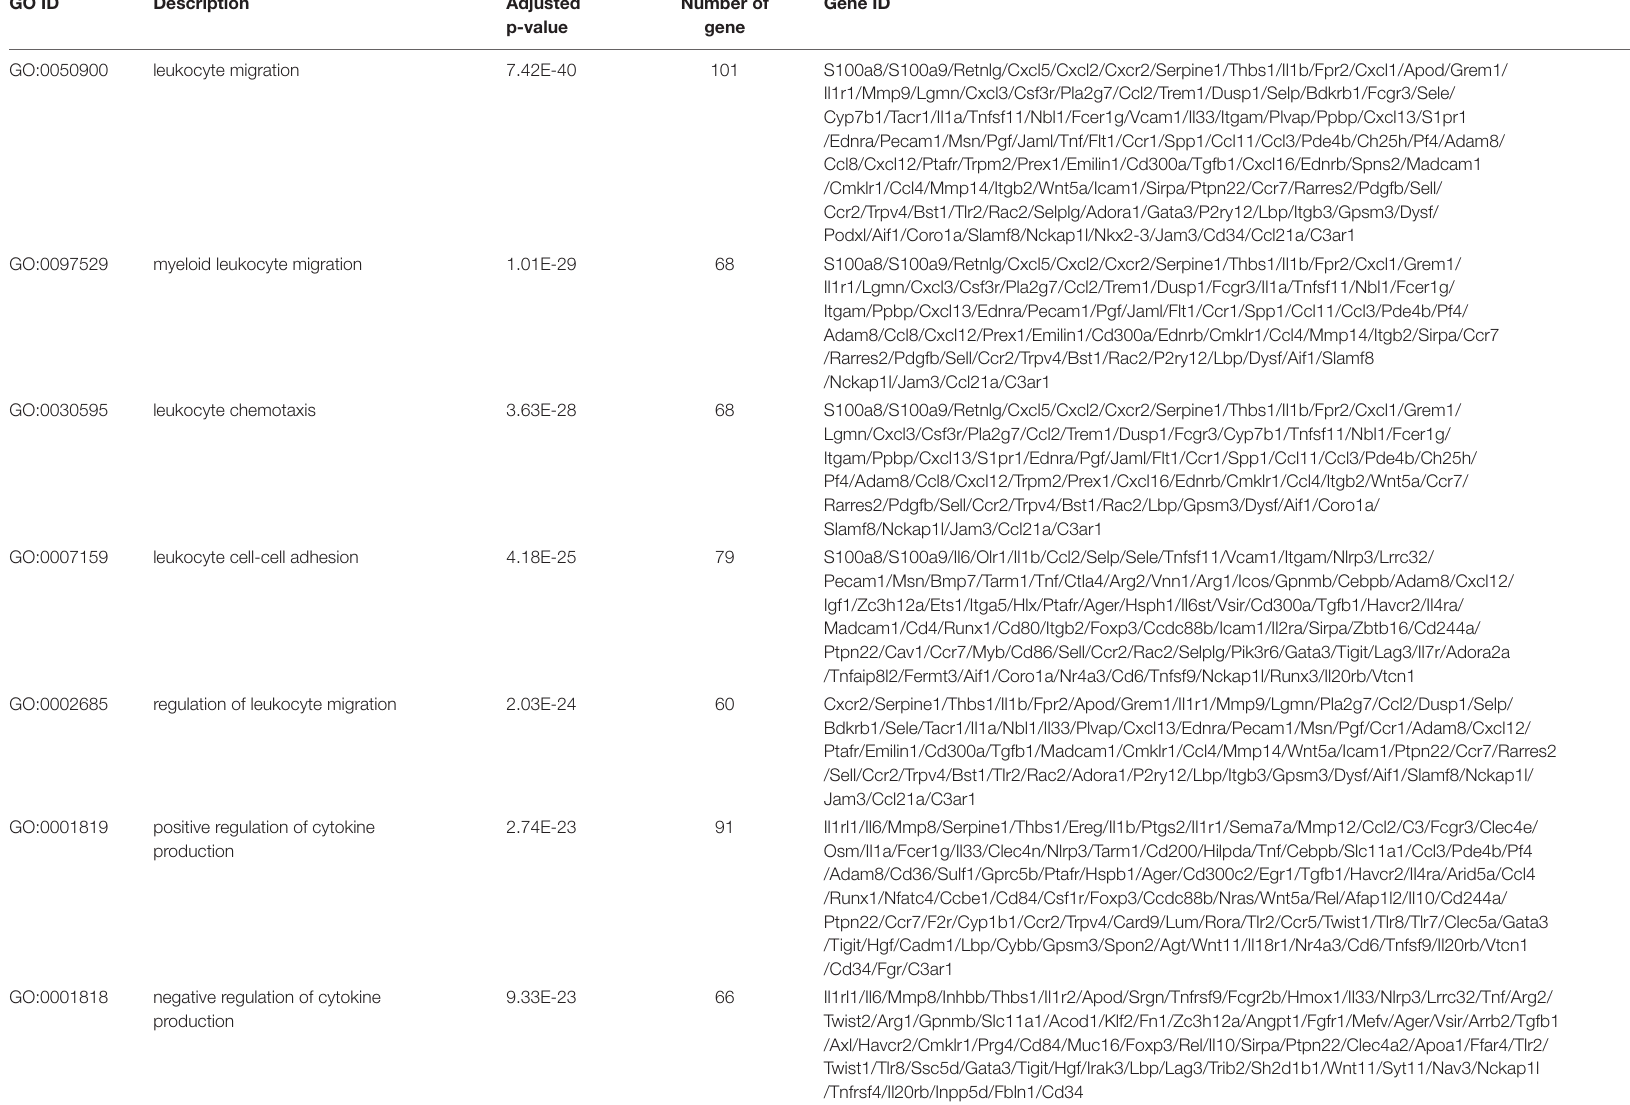
TABLE 3 | Effects of Mesalazine on the DSS-induced biological inflammatory